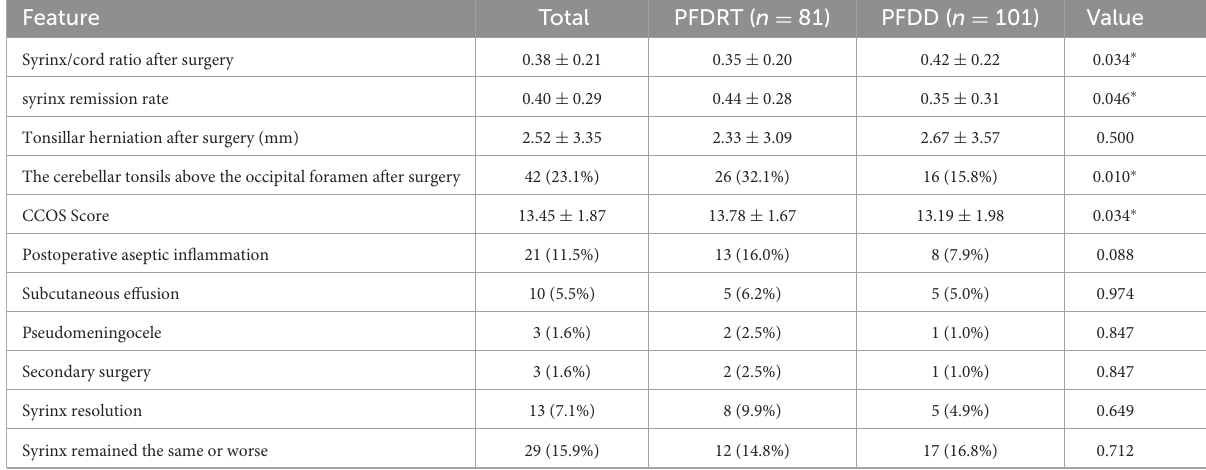
TABLE 2 Clinicoradiological characteristics after operation.